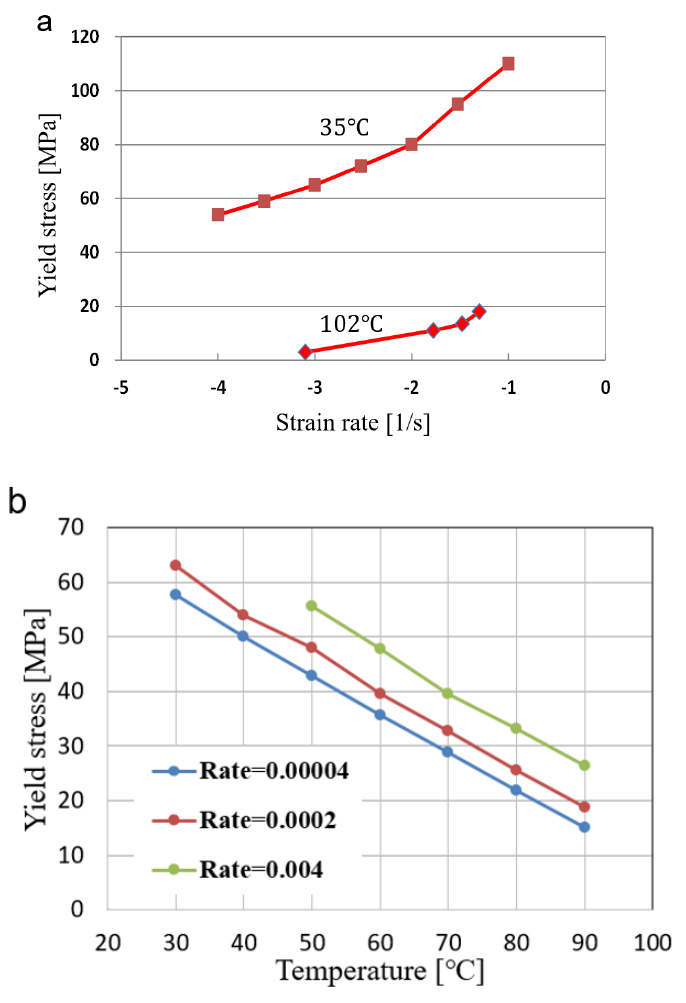
Figure 2. Yield stress variation with ( a ) temperature and ( b ) strain rate. (a) determining the coefficients of two straight lines at a given temperature as a function of temperature; (b) determining two straight lines at a given temperature using the coefficients of the line; (c) determining the flow stress using the strain